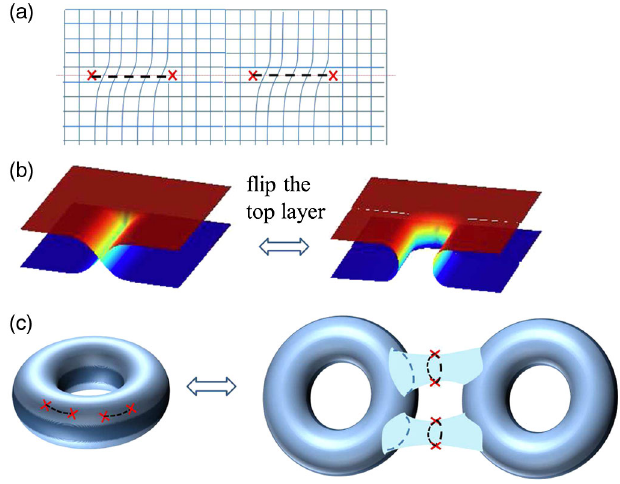
FIG. 2. (a) Illustration of an x dislocation. (b) Left panel: Illustration that an x dislocation leads to a branch cut around which the two effective layers are exchanged. Right panel: A reflection of the top layer maps the branch cut between a pair of dislocations into a wormhole connecting the two layers. (c) A torus with two pairs of x dislocations is equivalent to two tori connected by two wormholes, which is a genus-3 surface. This picture illustrates the fact that dislocations carry nontrivial topological